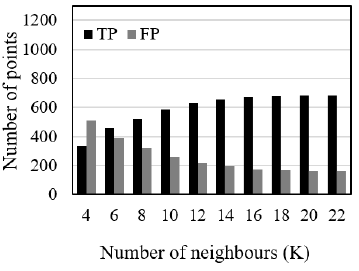
Figure 3. Effect of neighbouring points (K) on SOR filter,